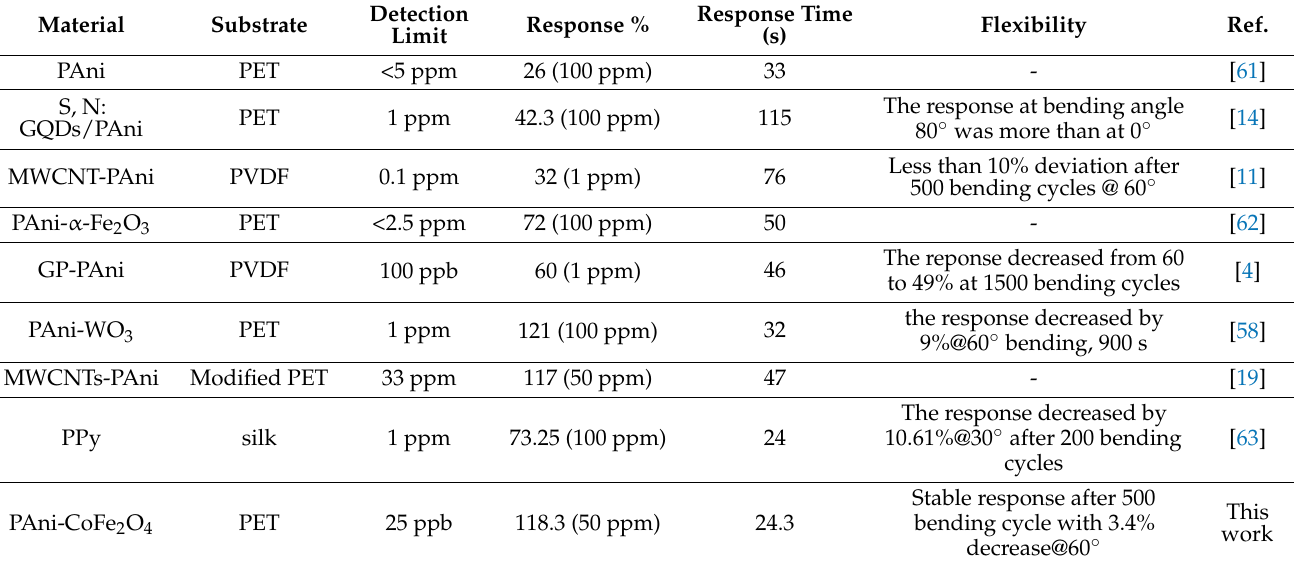
Table 1. The sensing properties comparison of PET-PAni-CoFe 2 O 4 (50%) with other reported works.